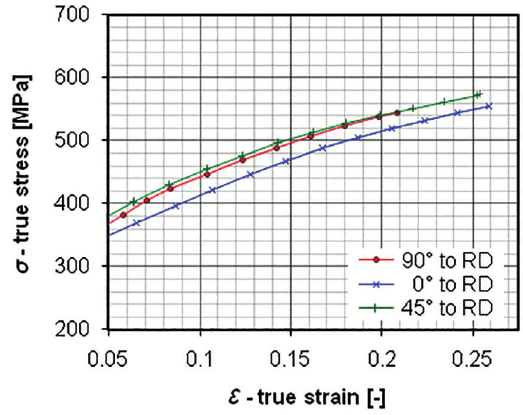
Figure 1: True tensile stress-strain flow curves along 0°, 45°, and 90° to